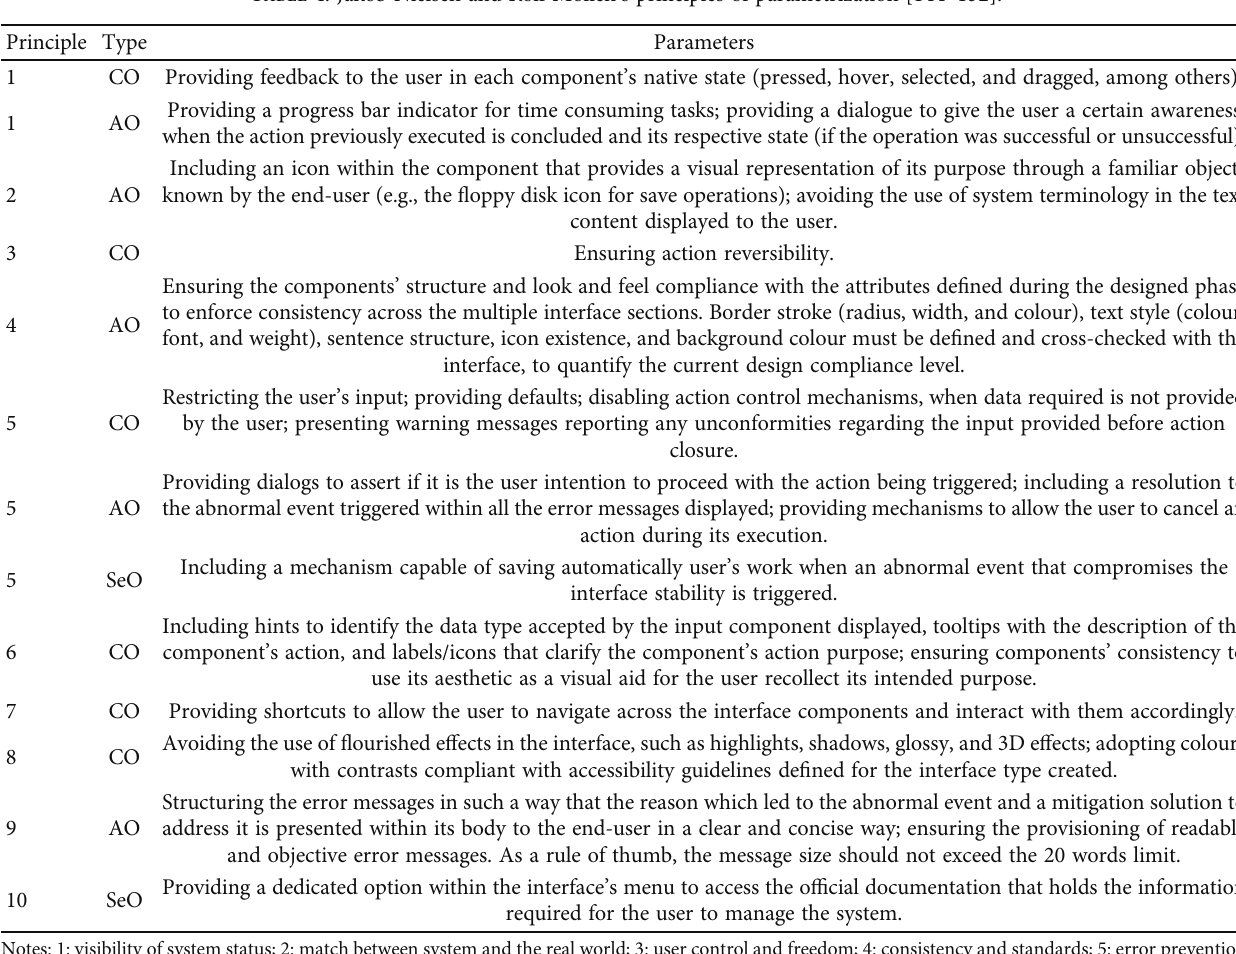
Table 4: Jakob Nielsen and Rolf Molich ’ s principles of parametrization [144 – 152].